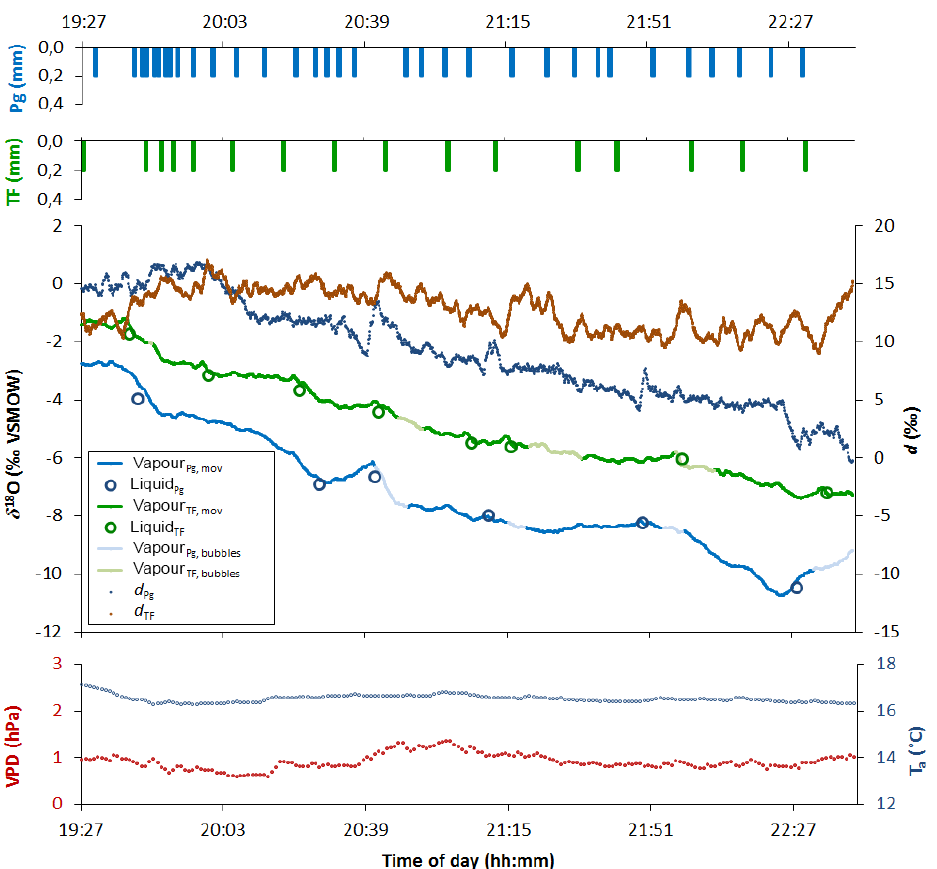
Figure 6. Time series of liquid water δ 18 O and d derived from vapour sampling of P g (blue) and TF (green), discrete liquid samples (big circles), air temperature ( T a ) (small blue circles), and vapour pressure deficit (VPD) (red) of the rainfall event from 4 August 2016. Time series of d P (dark blue dots), d TF (brown dots), and T a are referenced on the right vertical axes. Periods of intensities below the threshold g for the continuous sampling method (bubbles at the membrane contactor) are shown in light blue (P g ) and light green